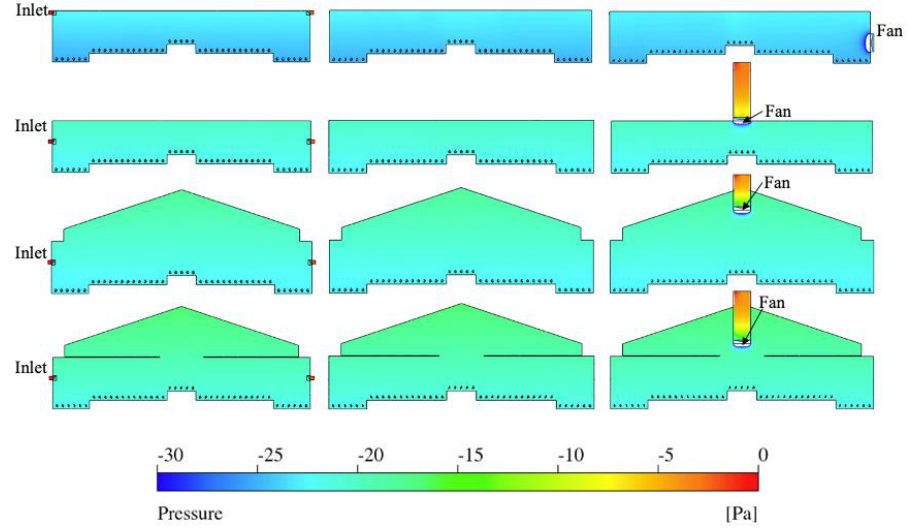
Figure 10. Indoor pressure contours of four models, from top to bottom rows: TISE, MICE, MIRE, and MIAE at three reference planes (columns from left to right: Plane I, Plane N, and Plane